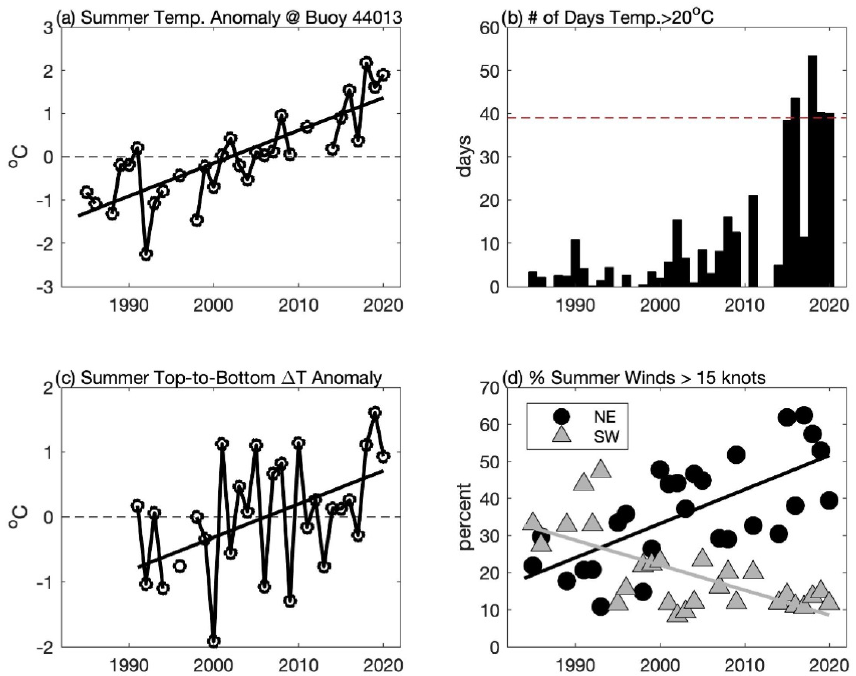
Figure 7. Changes in summer (June–September) conditions in CCB including (a) mean surface water temperature anomaly at the NDBC buoy 44013, (b) total number of days when surface water temperature exceeded 20 ◦ C at the NDBC buoy 44013, (c) temperature difference anomaly between NDBC buoy 44013 (surface) and MDMF Wreck of the Mars ( ∼ 33m depth), and (d) percentage of time that summer winds in excess of 15kn (7.7ms − 1 ) are from the northeast (black circles) and from southwest (grey triangle). Solid lines in (a) , (c) , and (d) are linear regressions, all of which are significant at p < 0.05. In (a) and (b) , the anomalies are simply calculated by removing the mean over the period of